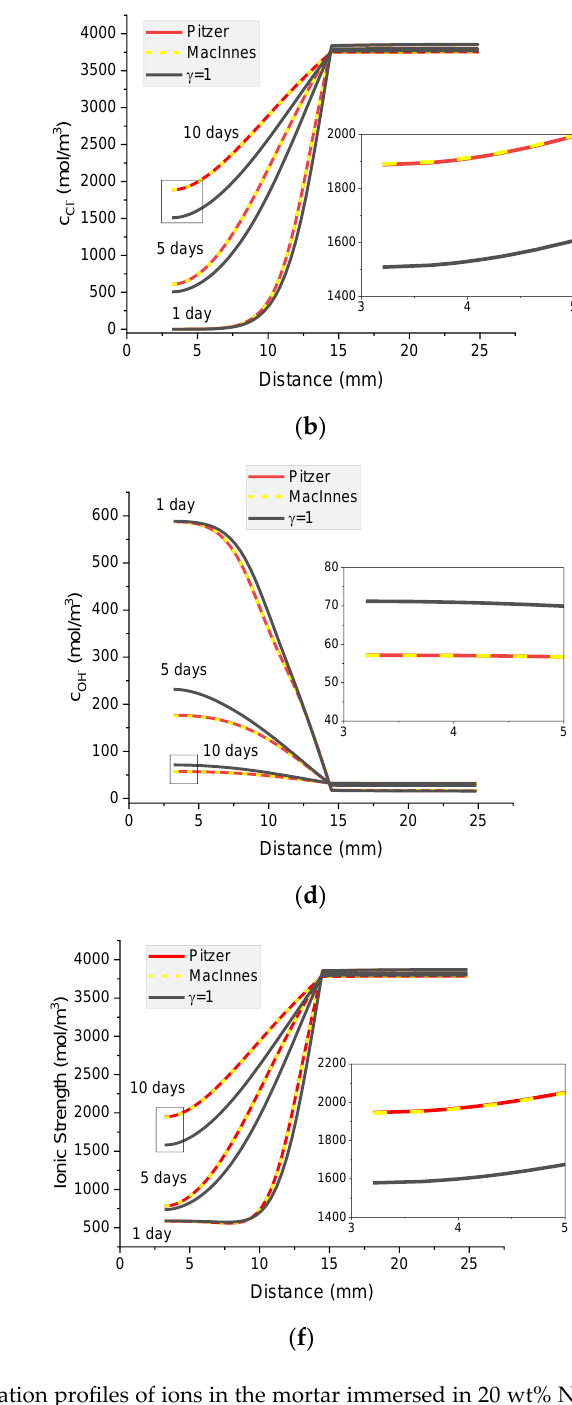
Figure 16. Calculated concentration profiles of ions in the mortar immersed in 5 wt% NaCl water solution. ( a ) Na + ; ( b ) Cl − ; ( c ) K + ; ( d ) OH − ; electrical potential ( e ) and ionic strength ( f ) after 1, 5, and 10 days.